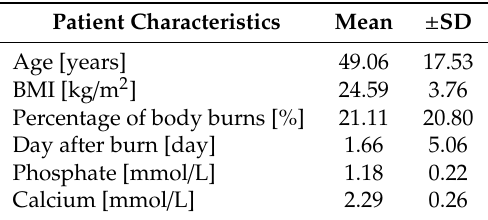
Table 2. Patient characteristics.